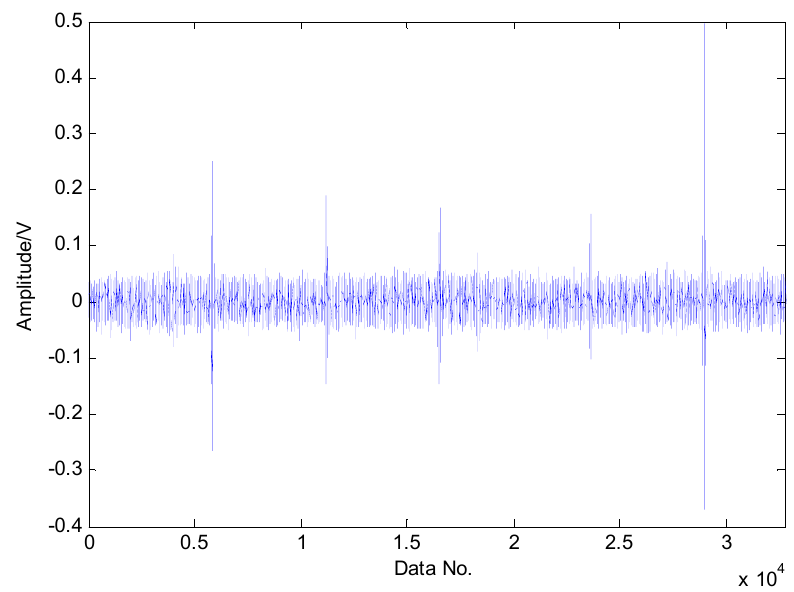
Figure 9. Original vibration signals collected from roller bearing with an inner-race fault.